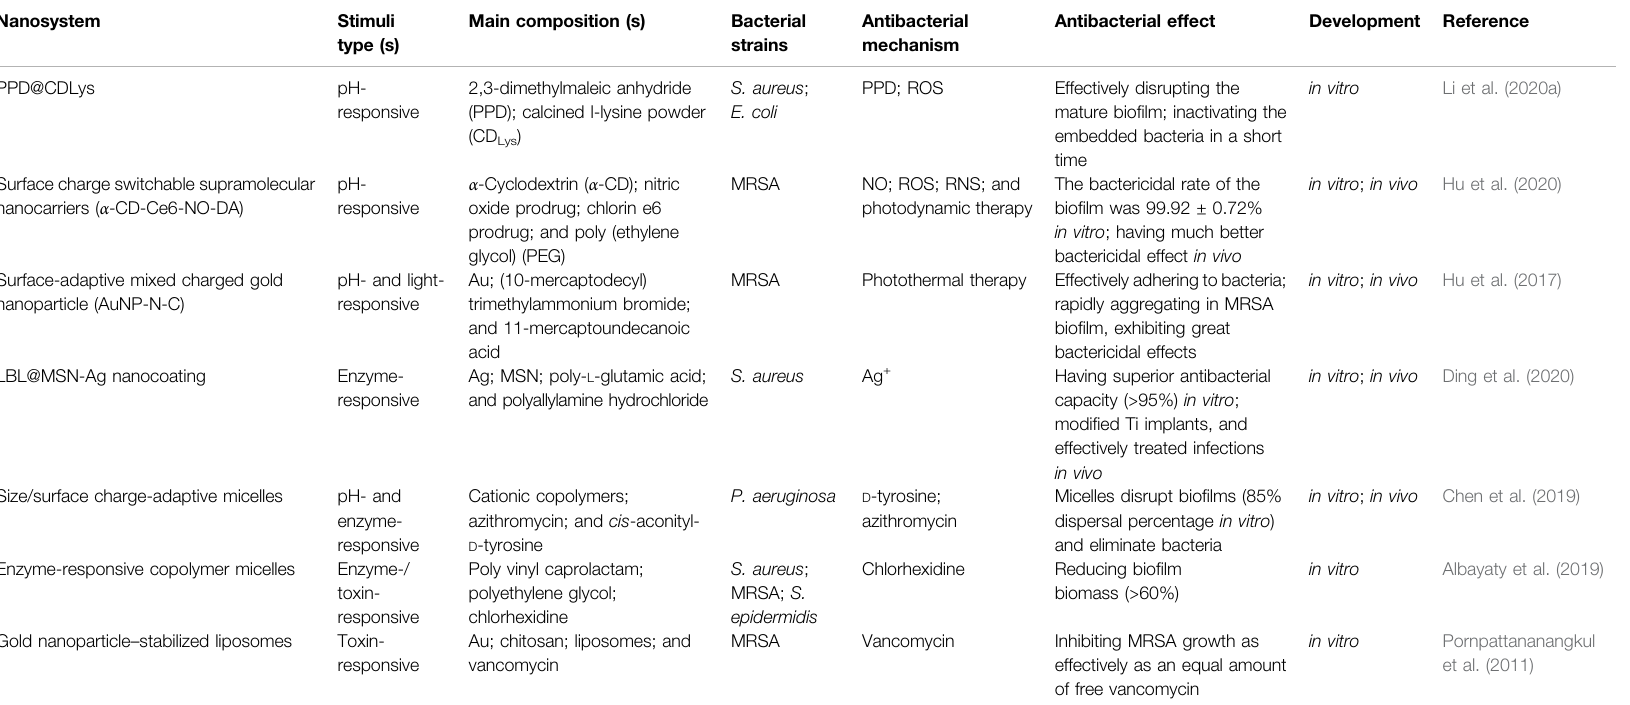
TABLE 1 | ( Continued ) Stimuli-responsive nanomaterials with antibacterial